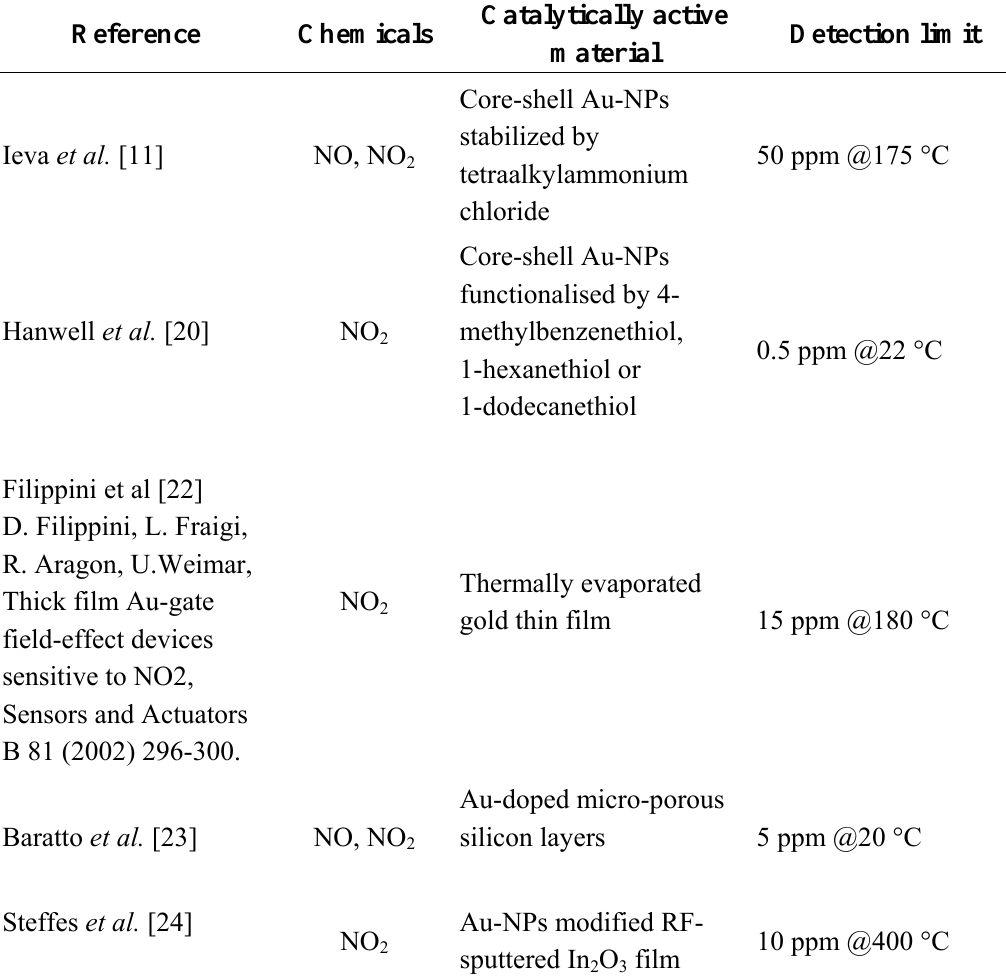
Table 2. State of art Au-NPs based sensor performances for NO